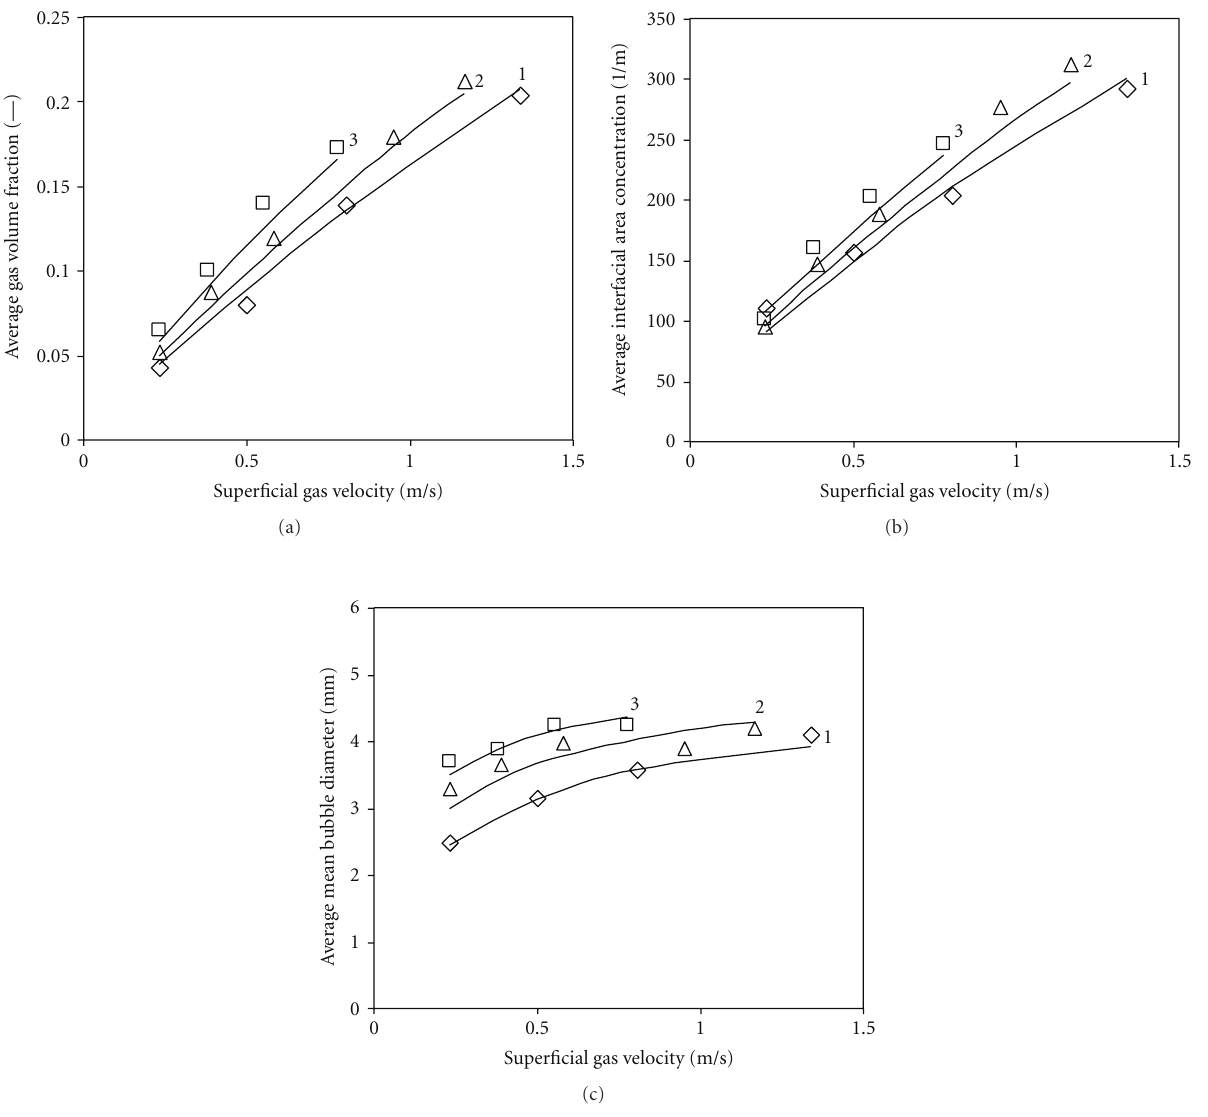
Figure 10: E ff ect of superficial gas and liquid velocity on (a) average gas volume fraction; (b) average interfacial area concentration (c) average mean bubble diameter: (1) V L = 5 . 1m/s; (2) V L = 4 . 4 m/s; (3) V L = 3 . 74 m/s.